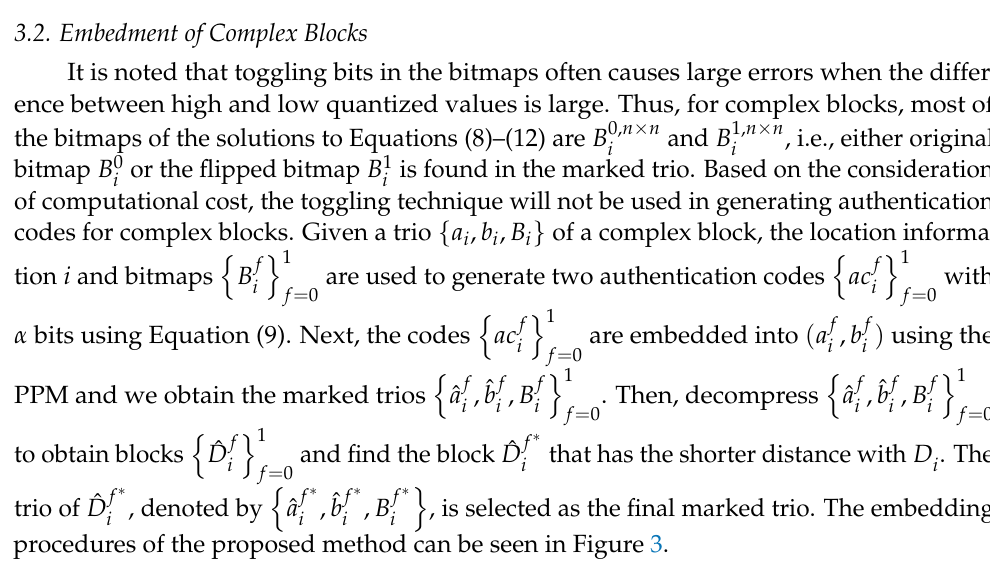
R . Figure 2. Partial reference table of R PPM 4 4